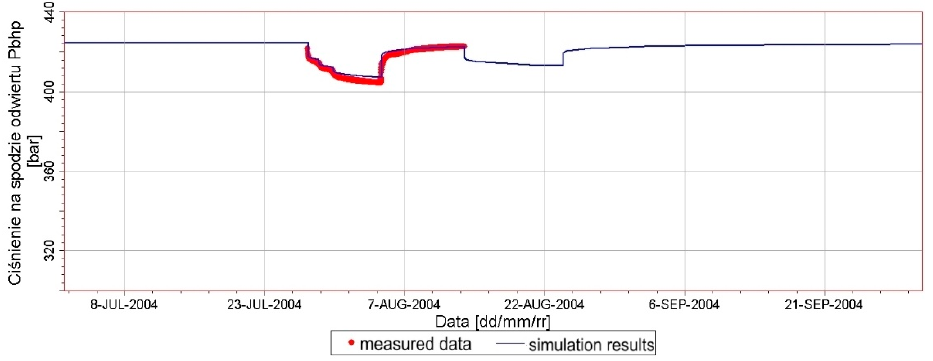
Figure 13. Bottom-hole pressure variation at well A-4.